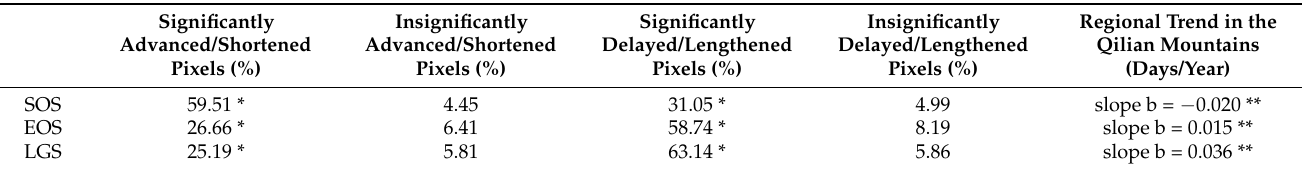
Table 1. The overall trend and proportion of different trends of phenology from 1982 to 2014 in the Qilian Mountains.